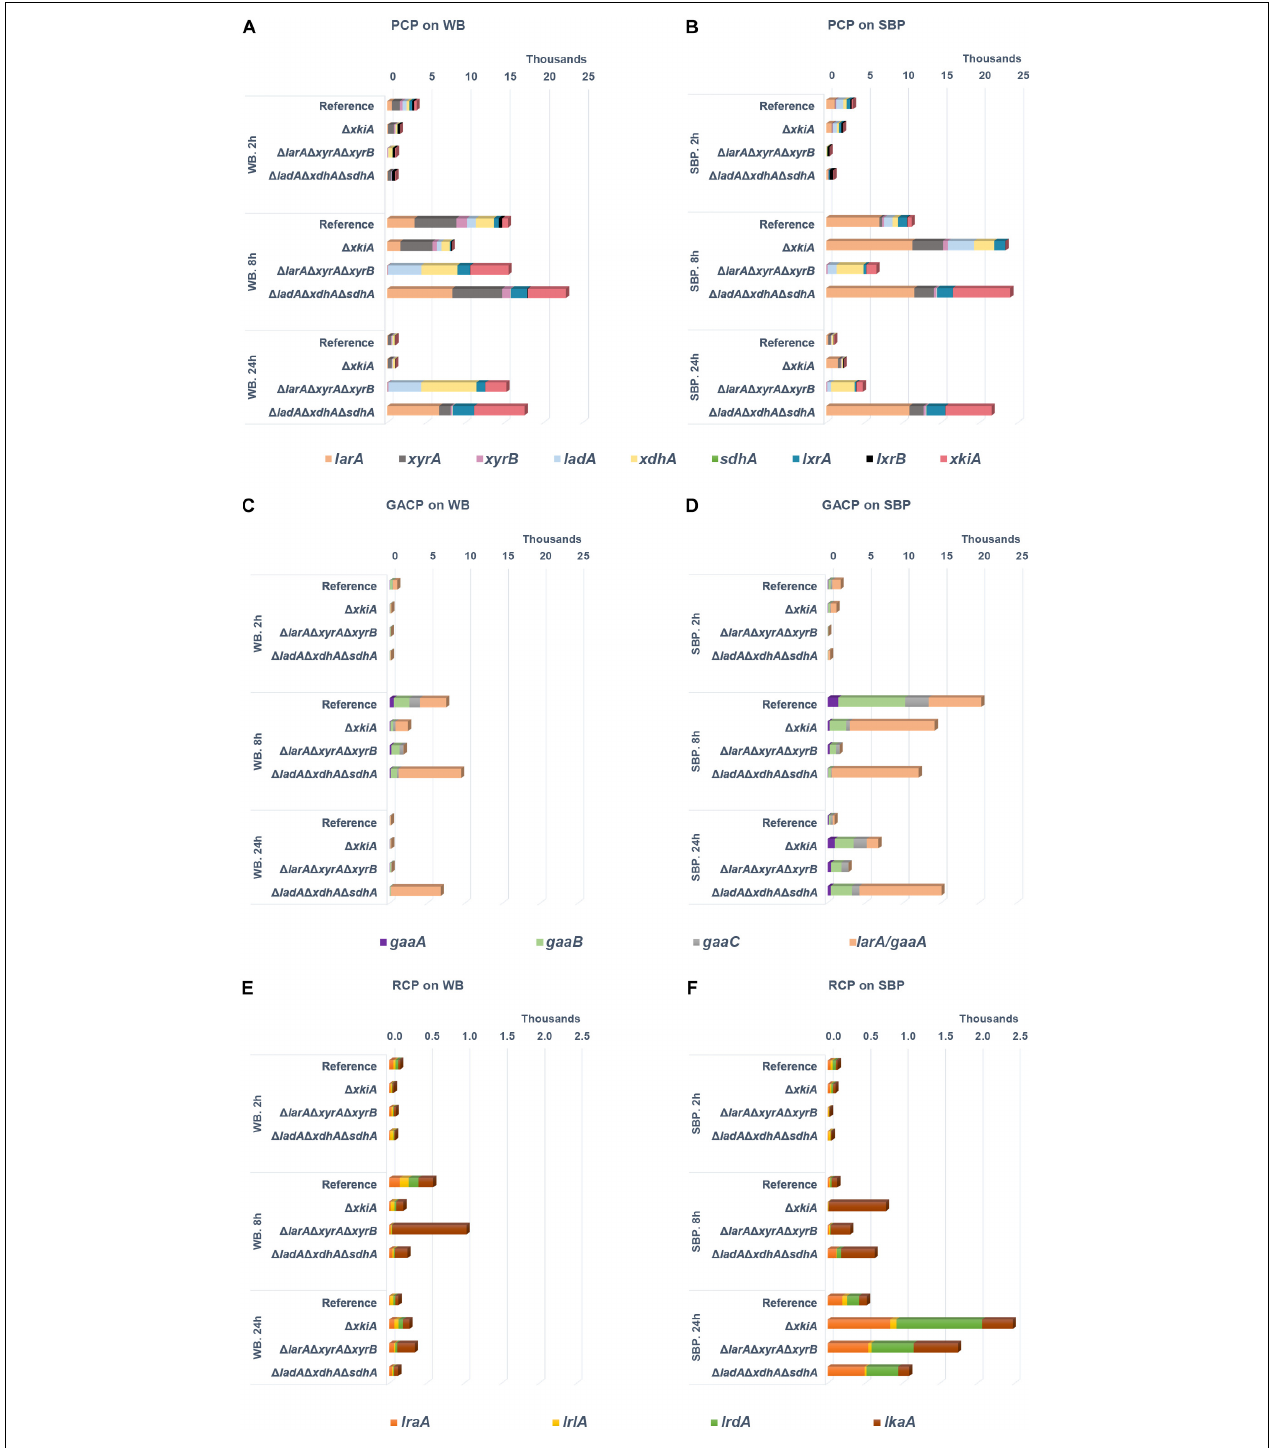
FIGURE 3 | Expression levels (FPKM) of catabolic genes during growth on (A,C,E) wheat bran (WB) and (B,D,F) sugar beet pulp (SBP) in the A. niger reference strain (N593 (cid:49) kusA ) and the PCP deletion mutants. PCP, pentose catabolic pathway; GACP, D -galacturonic acid catabolic pathway; RCP, L -rhamnose catabolic pathway. Genes encoding L -arabinose reductase ( larA ), L -arabitol dehydrogenase ( ladA ), L -xylulose reductases ( lxrA and lxrB ), sorbitol dehydrogenase ( sdhA ), D -xylose reductases ( xyrA and xyrB ), xylitol dehydrogenase ( xdhA ), D -xylulose kinase ( xkiA ), D -galacturonic acid reductase ( gaaA ), L -galactonate dehydratase ( gaaB ), 2-keto-3-deoxy- L -galactonate aldolase ( gaaC ), L -glyceraldehyde reductase ( larA / gaaD ), L -rhamnose-1-dehydrogenase ( lraA ), L -rhamnono- γ -lactonase ( lrlA ), L -rhamnonate dehydratase ( lrdA ), L -2-keto-3-deoxyrhamnonate aldolase ( lkaA ).